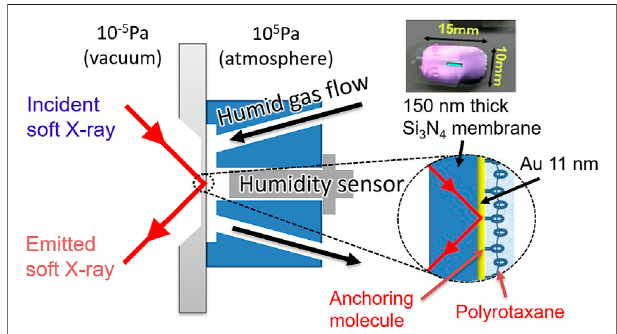
FIGURE 1 | Schematic image of a sample cell for soft X-ray absorption and emissionspectroscopy.Polyrotaxanepolymerswere fi xedonto anAu/Ti- coated 150 nm thick Si 3 N 4 membrane using an anchoring molecule and exposed to N 2 gas fl ow with precisely controlled